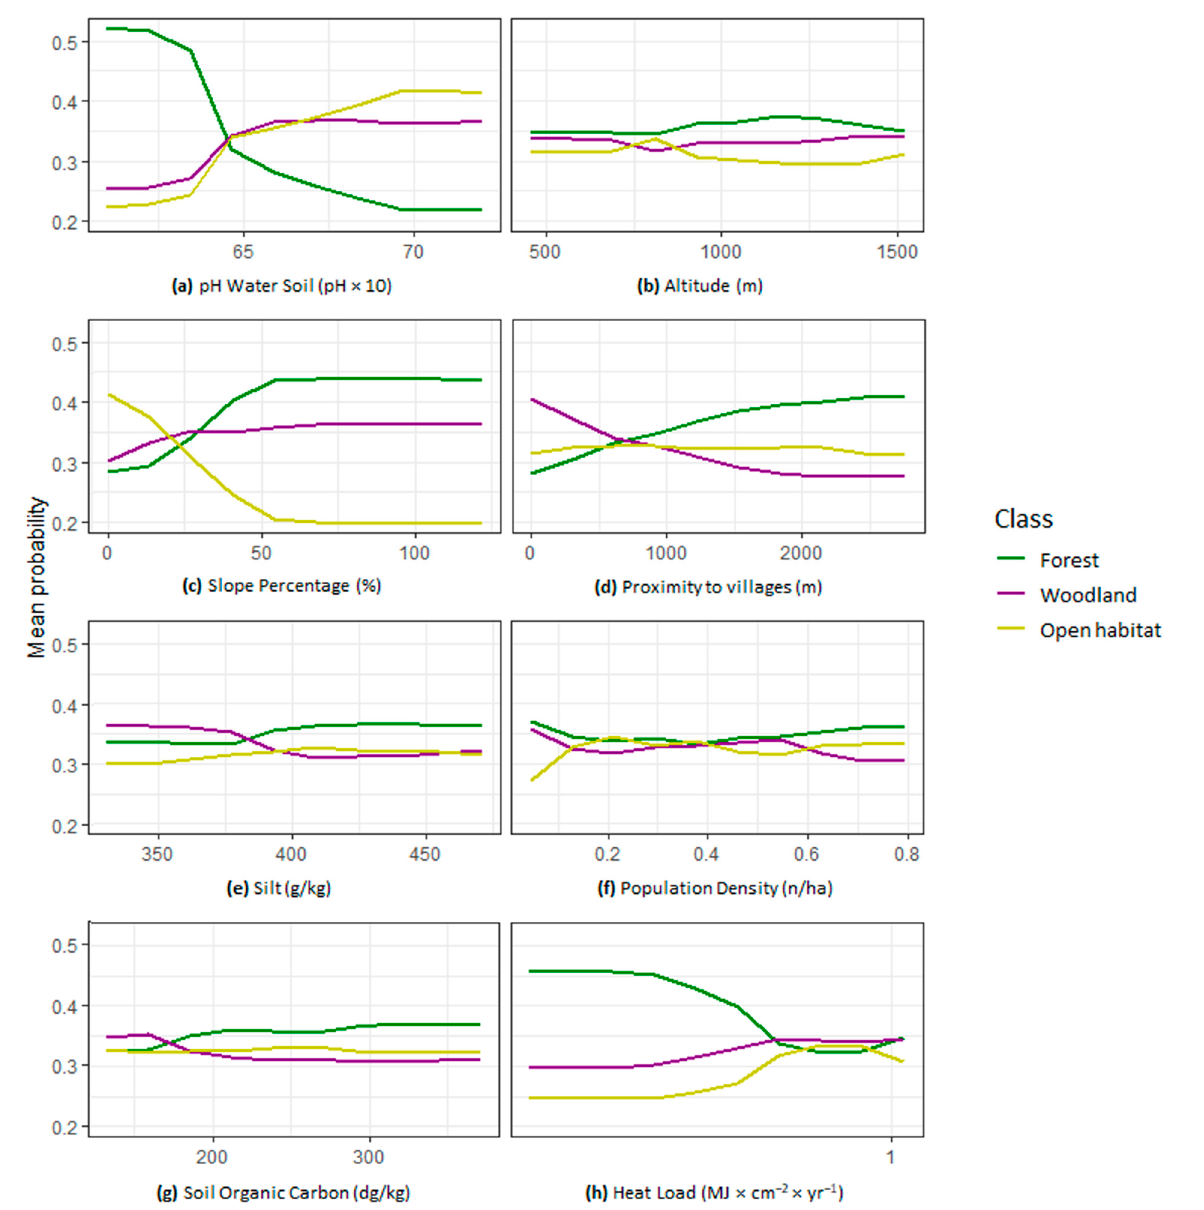
Figure 8. Partial Dependence Plots (PDP) showing the mean marginal effect of the explanatory variables with the highest importance in the RF model.